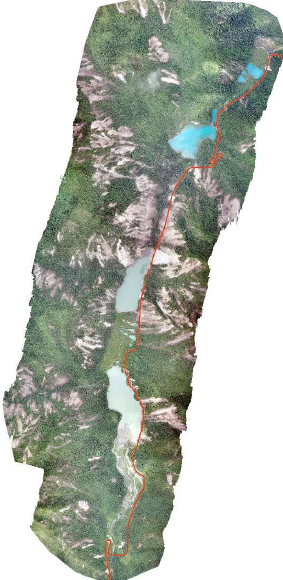
Figure 2. UAV images and road vector